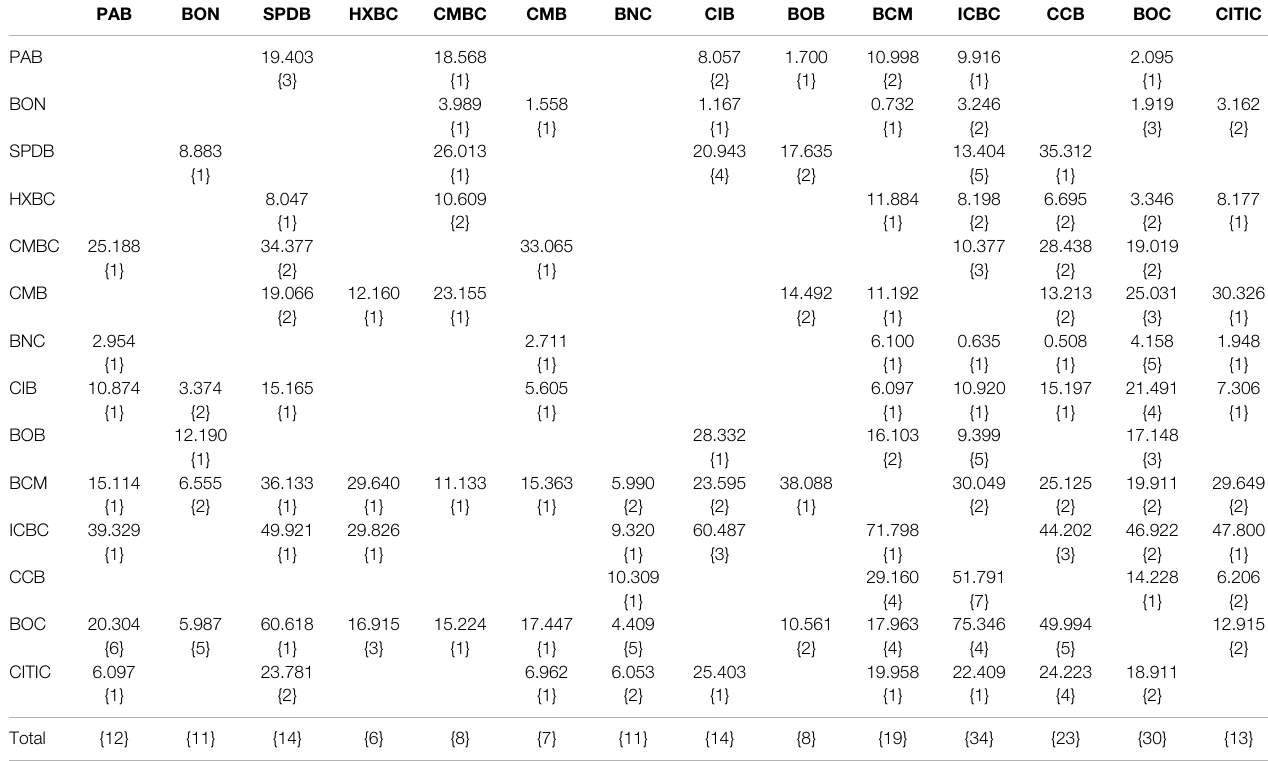
TABLE 3 | Statistics of interbank lending networks from 2008 to 2018.